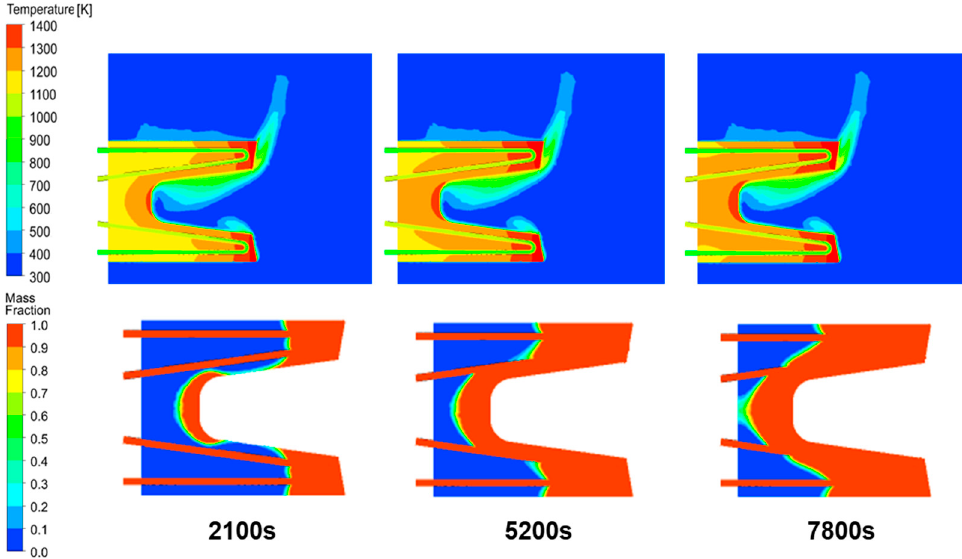
Figure 8. Contours of temperatures and PCM liquid fraction during the charge process.